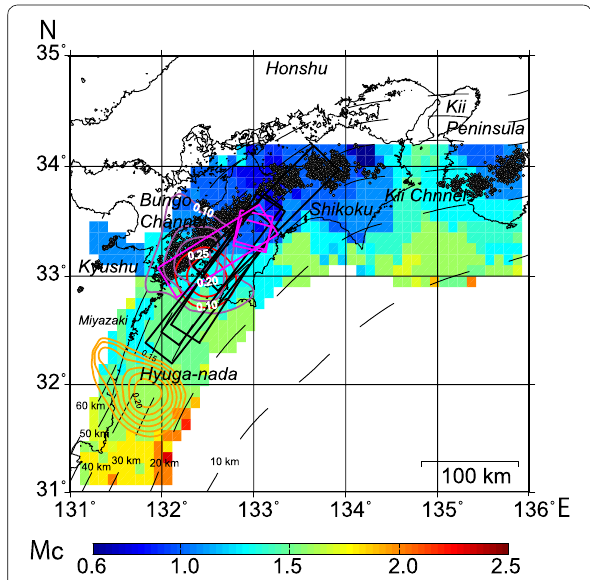
Fig. 2 Spatial distribution of catalog completeness magnitude, Mc, estimated using the maximum curvature method (Wiemer and Wyss 2000) on a grid with 0.1° horizontal spacing. Events were extracted in a 35-km radius around each node. Purple and red contours represent isoslip values due to 2003 and 2010 SSEs in the Bungo Channel (Ozawa et al. 2013; Ozawa 2017), with labels in meters and an increment of 0.05 m. Orange contours represent the cumulative slip distribution due to 1997, 2005, 2007, and 2009 SSEs in southern Miyazaki district (Yarai and Ozawa 2013), with labels in meters and an increment of 0.01 m. Purple and black rectangles represent faults corresponding to SSEs from 2004–2006 to 2011–2013 in western Shikoku (Takagi et al. 2016). Gray circles show LFE locations obtained from the JMA